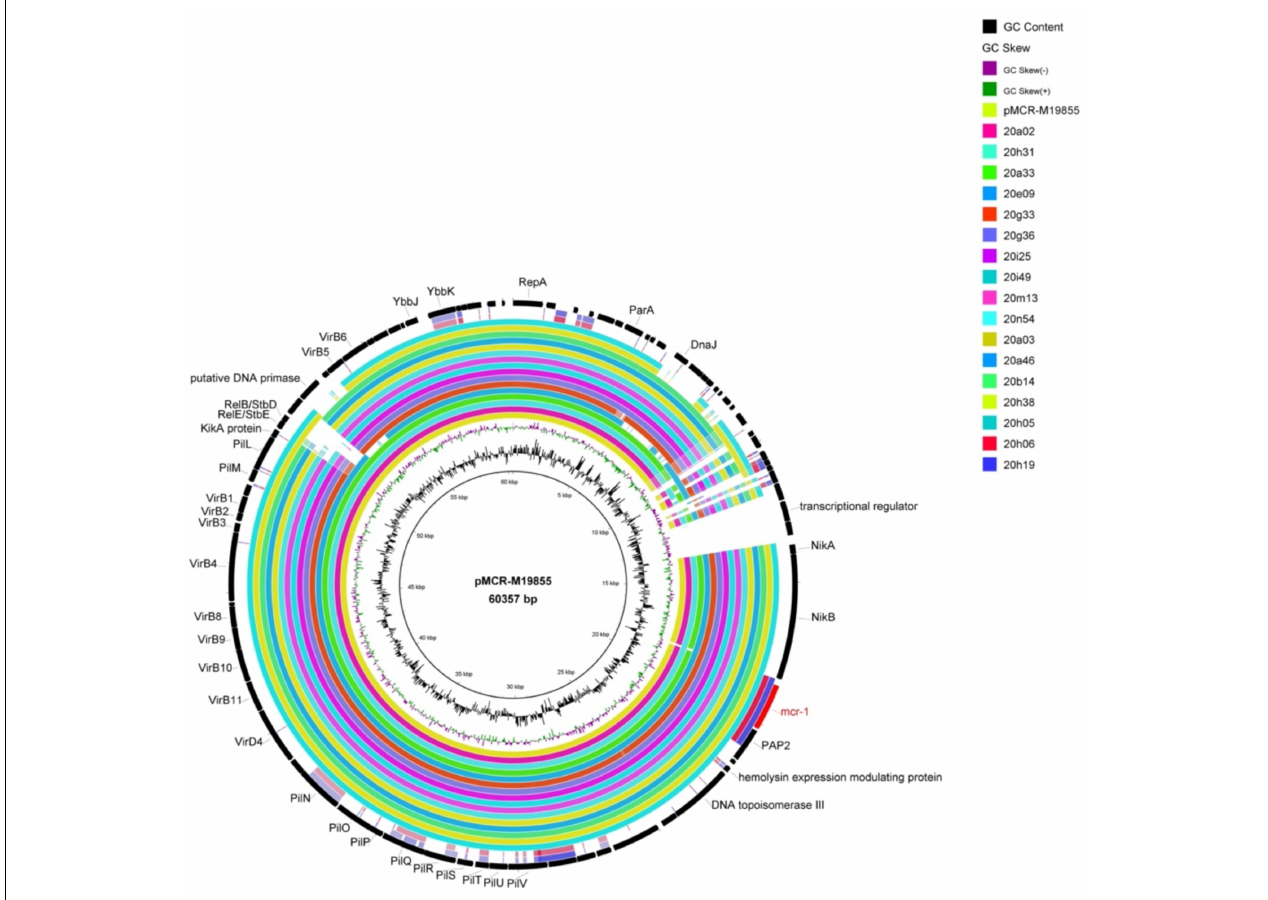
FIGURE 2 | Comparison of whole-genome sequences of MCRPEC against the sequence of mcr-1 -carrying plasmid pMCR-M19855 (GenBank accession no. KY471315). The first ring from the inside and the coordinates correspond to pMCR-M19855. Each ring represents one of the genomes, and the outside ring represents the regions from the 17 MCRPEC strains in this